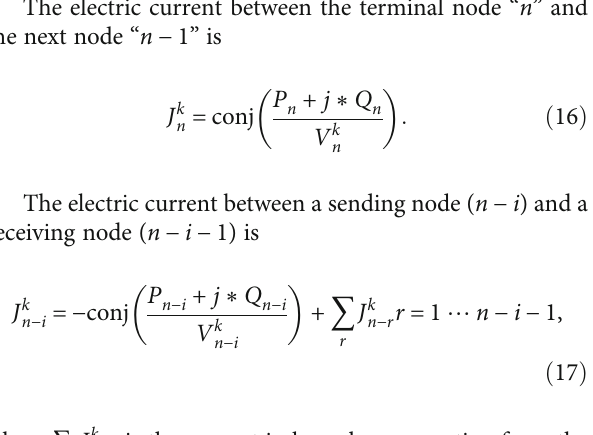
the open point: structure no. 1 (open point) at the node “ 15A-5B, ” structure no. 2 at the node “ 3B, ” and